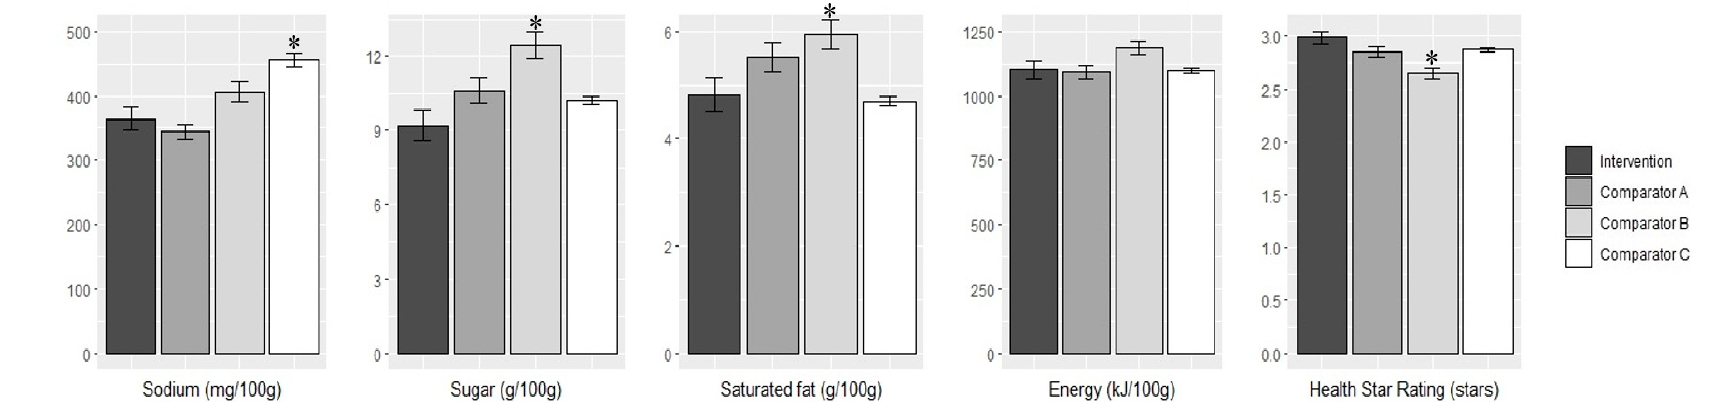
Figure 1. Comparison of the mean nutrient content [sodium (mg/100 g), sugar (g/100 g), saturated fat (g/100 g) and energy (kJ/100 g)] and Health Star Rating in 2015 between the intervention supermarket and comparators. Errors bars indicate the standard error (SE). Differences across groups were estimated using 1-factor ANOVA tests with Tukey’s honest significance difference test post-hoc analyses. * indicates significance difference compared to intervention supermarket ( p < 0.05).